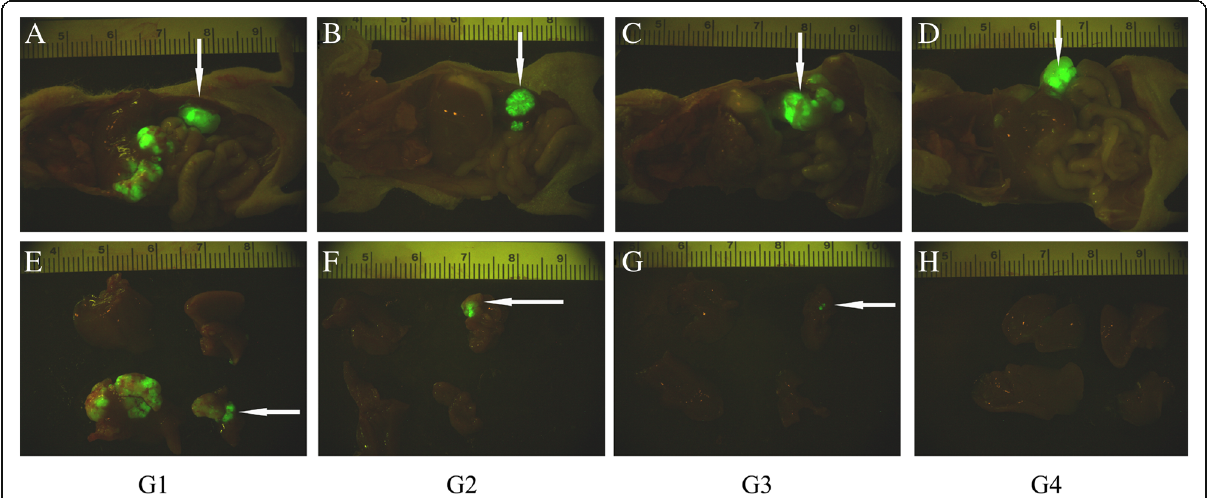
Fig. 2 Representative images of colon cancer liver metastasis in different groups. a - d : Images of mice anatomy showing inner organs. The arrows pointing down indicated the transplanted tumor in the spleen. e - h : Images of mice livers and the arrows pointing left indicated the metastasis tumors. a , e : G1-Control group (normal saline, intragastric administration twice a day for 3 weeks); b , f : G2 – 5-Fu group (15 mg/kg intraperitoneal injection twice a week for 3 weeks); c , g : G3-MSJZ group (45 g/kg intragastric administration twice a day for 3 weeks); d , h : G4-Combined group (15 mg/kg 5-Fu, intraperitoneal injection twice a week and 45 g/kg MSJZ, intragastric administration twice a day for 3 weeks). 5-Fu: 5- fluorouracil; MSJZ: modified Si-Jun-Zi Decoction